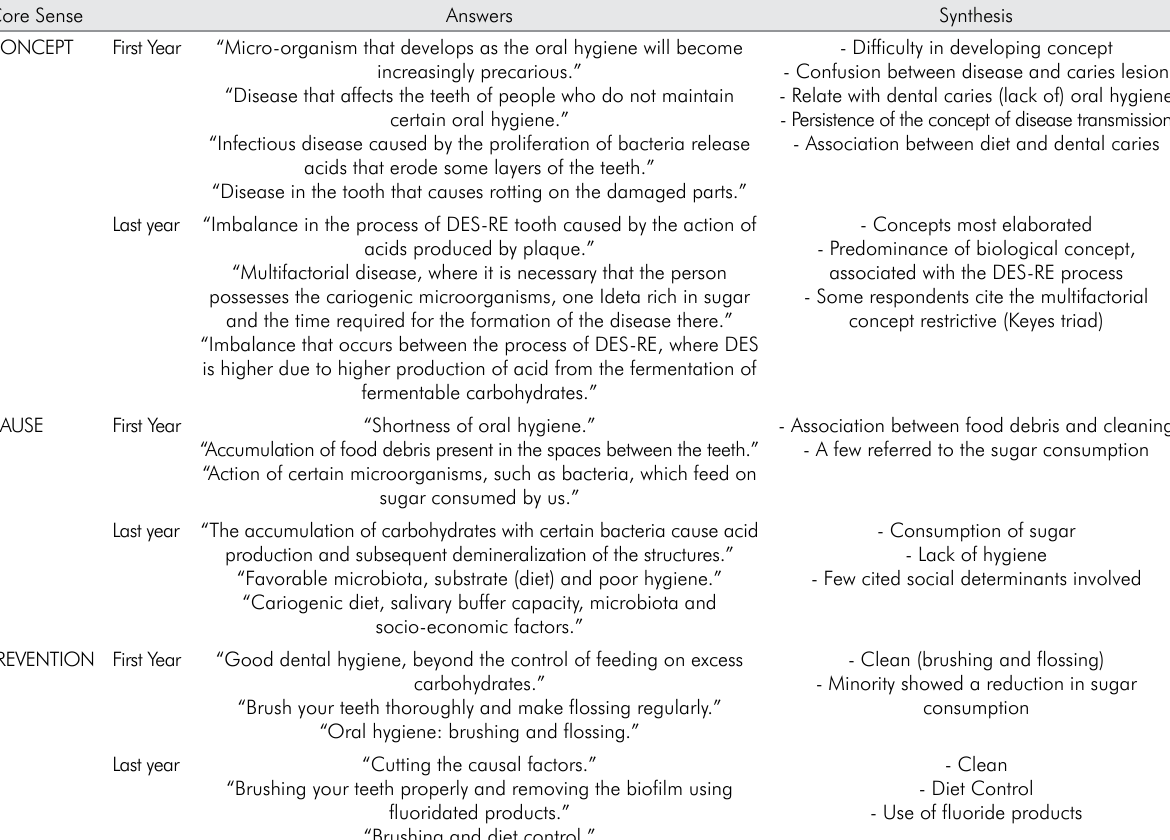
Table 2. Knowledge about dental caries of students (n=76), FOP/UNICAMP 2011. Core